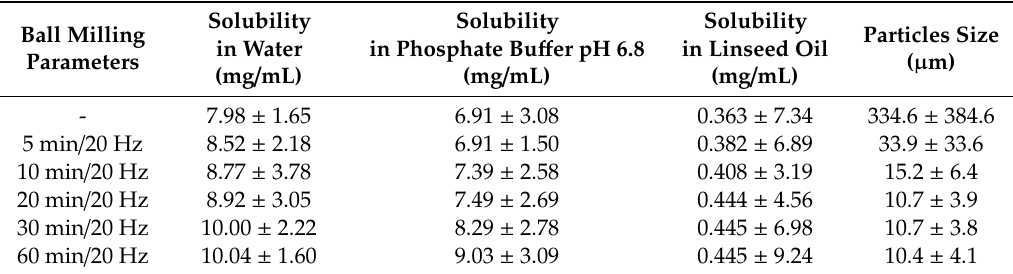
Table 2. Particles size and solubility in various solvents of unmilled metronidazole (MET) and metronidazole milled for 30 min at 20 Hz